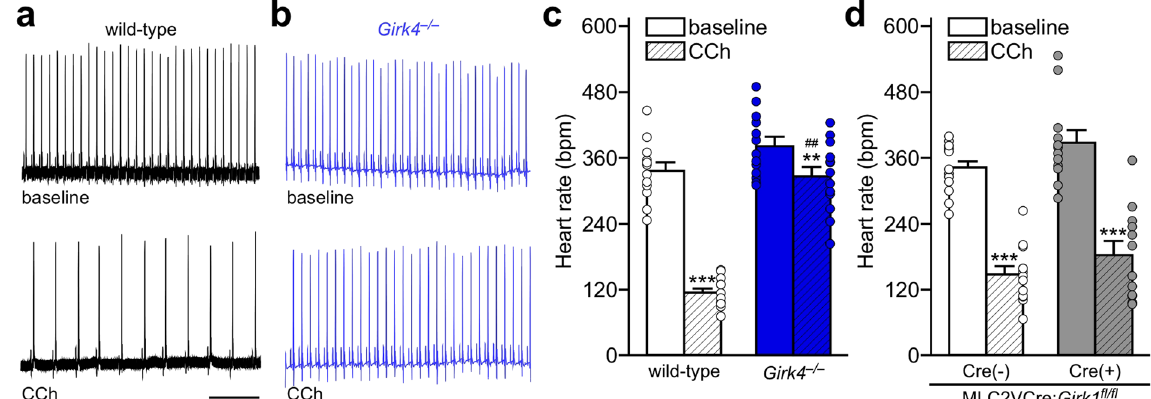
Figure 5. HR analysis of constitutive and ventricle-specific Girk − / − mice. ( a , b ) Segments of ECG recordings from anesthetized wild-type ( a ) and Girk4 − / − ( b ) mice, at baseline and after injection of CCh (1.0 mg/kg i.p.). Scale: 1 s. ( c ) Summary of HR data at baseline and after injection of CCh for wild-type (n = 12) and Girk4 − / − (n = 13) mice. Two-way ANOVA analysis revealed an interaction between genotype and treatment (F 1,23 = 54.8, P < 0.001). Symbols: ** , *** P < 0.01 and 0.001, respectively, vs. baseline (within genotype); ## P < 0.01 vs. wild-type (within treatment). ( d ) Summary of HR data at baseline and after injection of CCh for MLC2VCre( + ): Girk1 fl/fl (n = 13) and MLC2VCre( − ): Girk1 fl/fl (n = 12) littermates. There was a significant main effect of treatment (F 1,23 = 173.1, P < 0.001), but no main effect of genotype (F 1,23 = 3.6, P = 0.070), or interaction between genotype and treatment (F